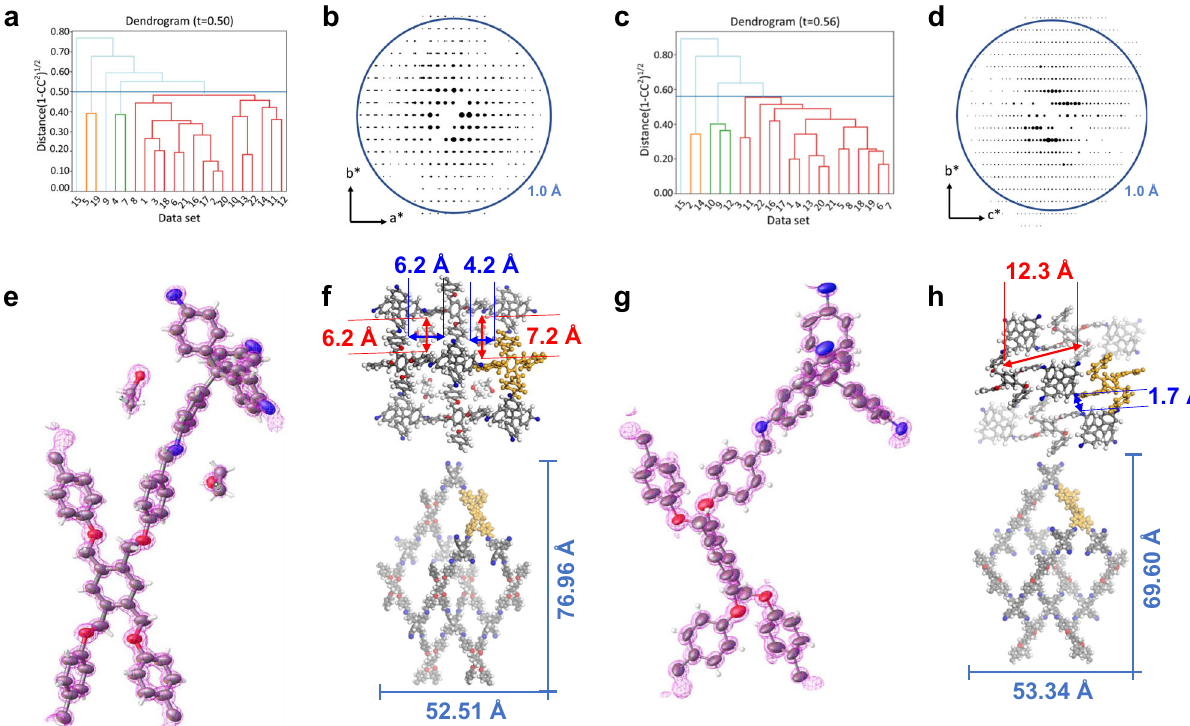
Fig. 2 HCA and structure of E-FCOF-5 and C-FCOF-5. The cut distance of HCA is represented in dendrogram by the blue line at 0.5 for E-FCOF-5 ( a ) and 0.56 C-FCOF-5 ( c ), which results in 16 cRED datasets belonging to the largest cluster for E-FCOF-5 ( a , in red) and E-FCOF-5 ( c , in red). The overview of 3D reciprocal lattices of E-FCOF-5 ( b ) and C-FCOF-5 ( d ) merged from 16 cRED datasets. The observed potential density maps of E-FCOF-5 ( e ) and C-FCOF-5 ( g ). The structures were re fi ned isotropically using soft restraints for the geometry of the phenyl rings as well as the C – C and C = N bond lengths. The observed peaks appeared to be spherical with similar peak heights for the same atom types. The porous structure of E-FCOF-5 ( f -up) and C-FCOF-5 ( h - up). The single pts net of E-FCOF-5 ( f -down) and C-FCOF-5 ( h same six-fold interpenetrated pts topology with E-FCOF-5 (Fig. 2h, right of Supplementary Fig. 7). The C-FCOF-5 structure was also re fi ned isotropically with soft restraints on the phenyl ring geometry as well as the C – C and C = N bond lengths and the observed peaks also appeared to be spherical with similar peak heights for the same atom types (Fig. 2g, Supplementary Fig. 21b).